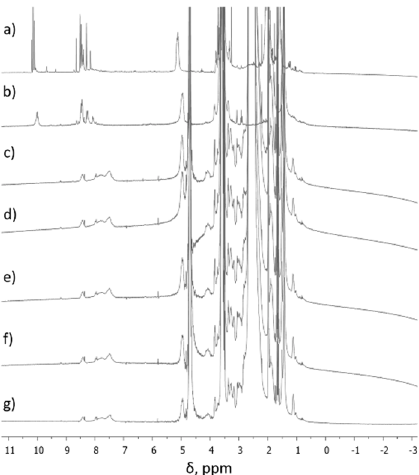
Figure 2. 1 H-NMR spectra of ( a ) intermediates (Ia, Ib) in CD 3 CN, ( b ) intermediates (Ia, Ib) in D 2 O, ( c ) F1 in D 2 O, ( d ) F2 in D 2 O, ( e ) F3 in D 2 O, ( f ) F4 in D 2 O, and ( g ) F5 in D 2 O.